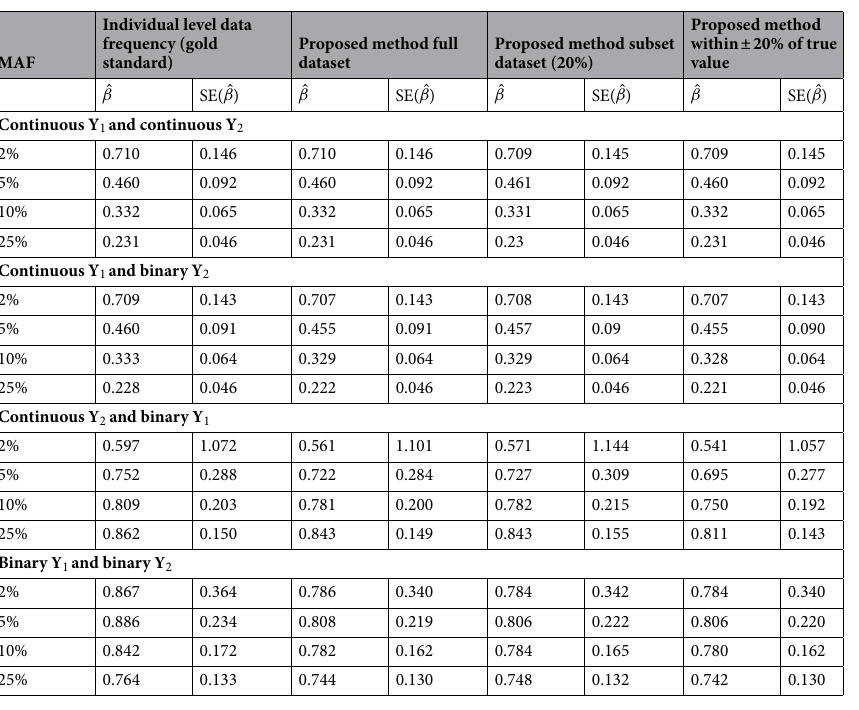
Table 1. Simulation results for genetic effect estimation of our method and the gold standard. Number in the table represent averages over all simulation replicates. MAF: minor allele frequency. Individual level data analysis is the gold standard for estimation. “Full dataset” means the relationship between the outcome and the covariate is estimated in the full sample of individuals, but the effect is estimated using our approximate approach. “Subset dataset” means the relationship between the traits is estimated by randomly selecting 200 individuals, or 20% of the total sample size. “Proposed method within ± 20% of true value” means the relationship between the outcome, and the covariate is a random estimate falling with 20% the true covariance between the traits. The latter scenario reflects what might happen when using estimates from published